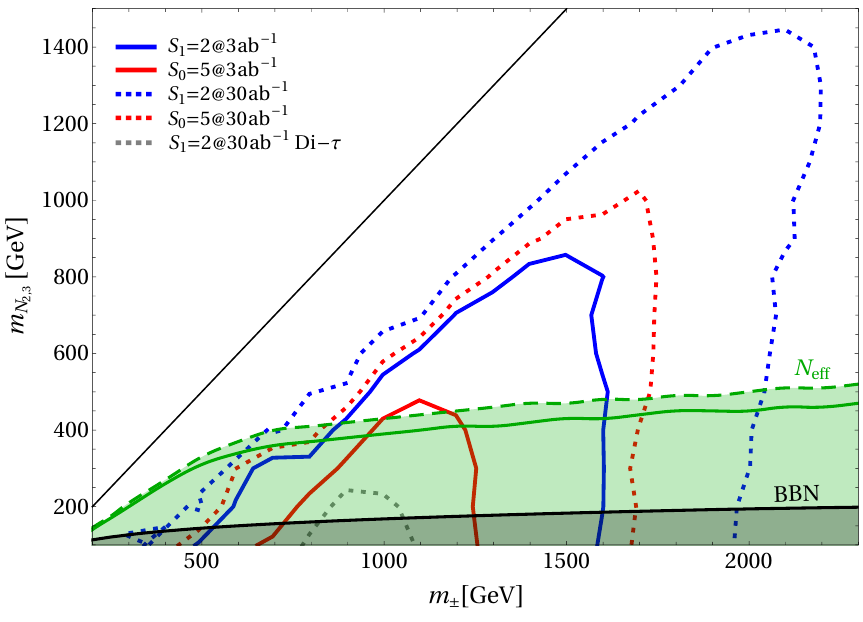
Figure 9 . Sensitivity of FCC-hh with = 3 ab (cid:0) 1 (30 ab (cid:0) 1 ) is shown with solid (dashed) lines. L The analysis is based on a proposed search for supersymmetry presented in ref. [66]. The red and blue curves correspond to the \best case" scenario with maximized couplings to e; (cid:22) . While the = 5 region for = 3 ab (cid:0) 1 is in tension with bounds from N e(cid:11) , = 2 extends to much higher S 0 L S 1 HNL masses, indicating that a signi(cid:12)cant portion of the parameter space can be probed at FCC-hh. The situation further improves for larger luminosity. The gray curve corresponds to the \worst" case in which couplings to tau-lepton are maximized; this case does not feature particularly strong sensitivity. The thin black line corresponds to m N = m 2 ; 3 (cid:6)